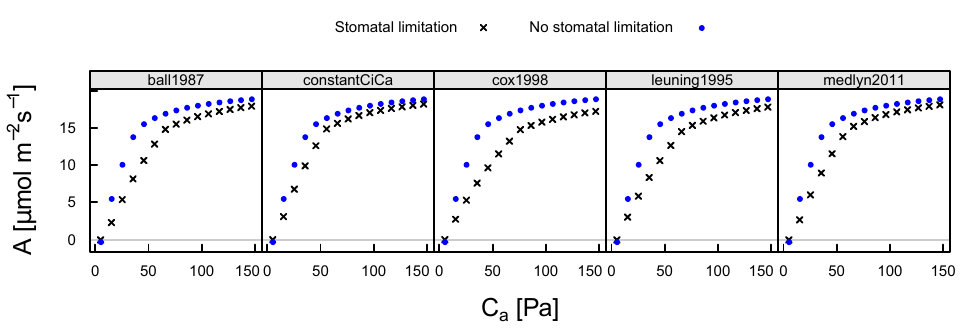
Figure 5. Comparison of A - C a curves with and without stomatal resistance (limitation) to carbon assimilation for the five representations of stomatal conductance; g 0 equal to 0.01.